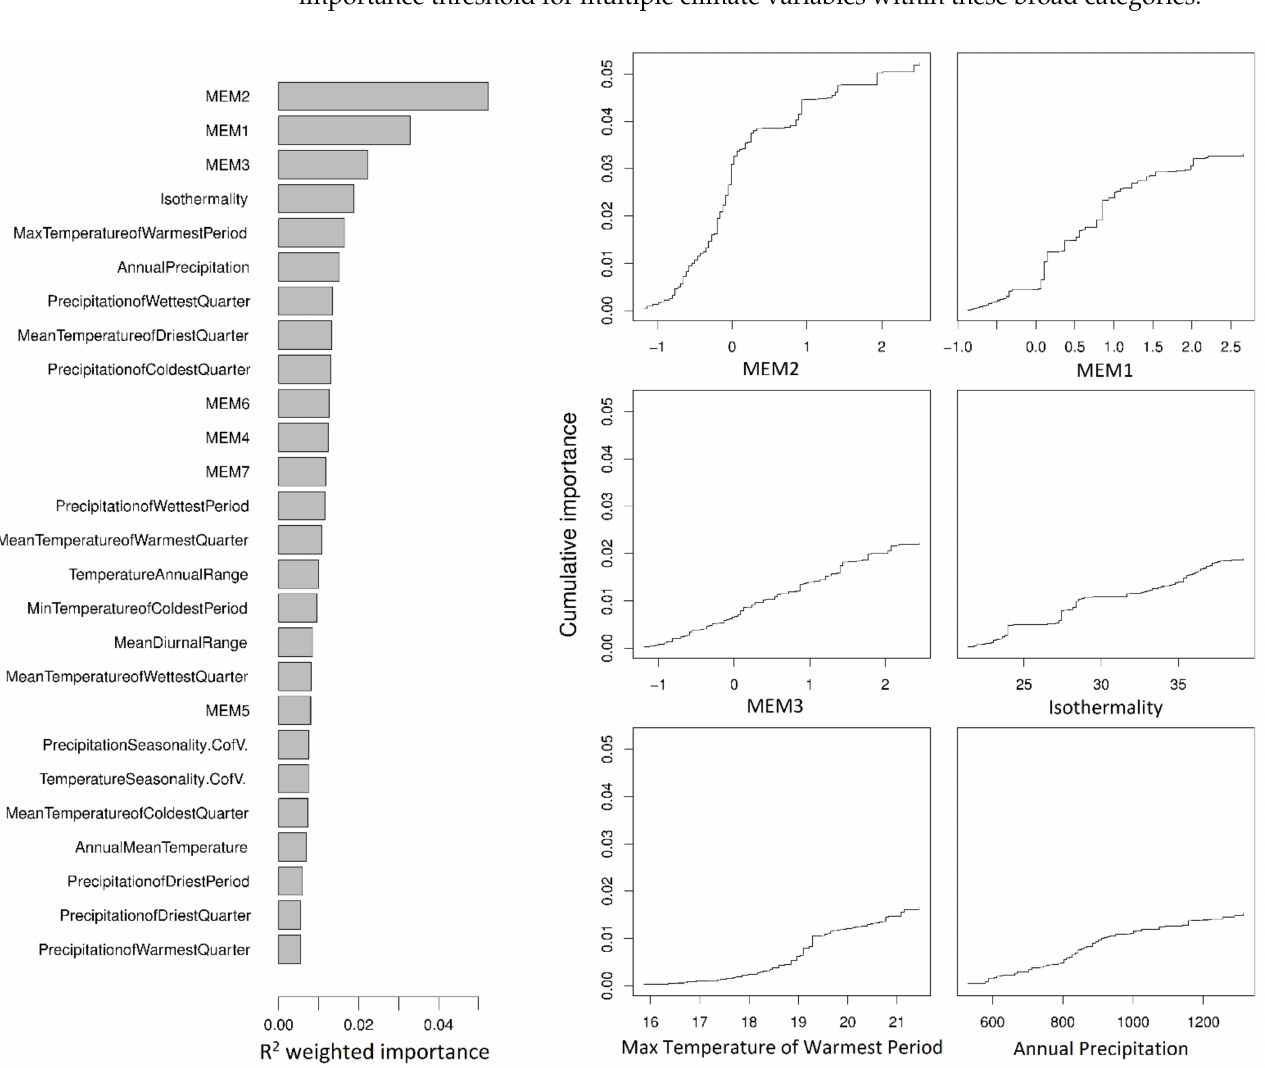
Figure 2. Relative importance of predictor variables (R 2 weighted, left) and cumulative importance of allele replacement in 71,183 SNPs across spatial (MEM1, MEM2, and MEM3) and climate gradients (right) as calculated by gradientForest. The three most important climate variables after accounting for spatial variation are shown. Values along the y axis represent change itself and have no directionality. Values along the x axis show the range of each variable. The modelled function shows how the total importance (or amount of allele replacement) associated with a variable is distributed across the range of that variable (e.g., the majority of the SNP differences associated with MEM2 are found between − 1 and 0.5). MEM1 was strongly correlated with longitude (Pearson’s r = − 0.84, p < 0.001), MEM2 with latitude (Pearson’s r = 0.79, p < 0.001) and MEM3 differentiated Furneaux Group island localities from all other